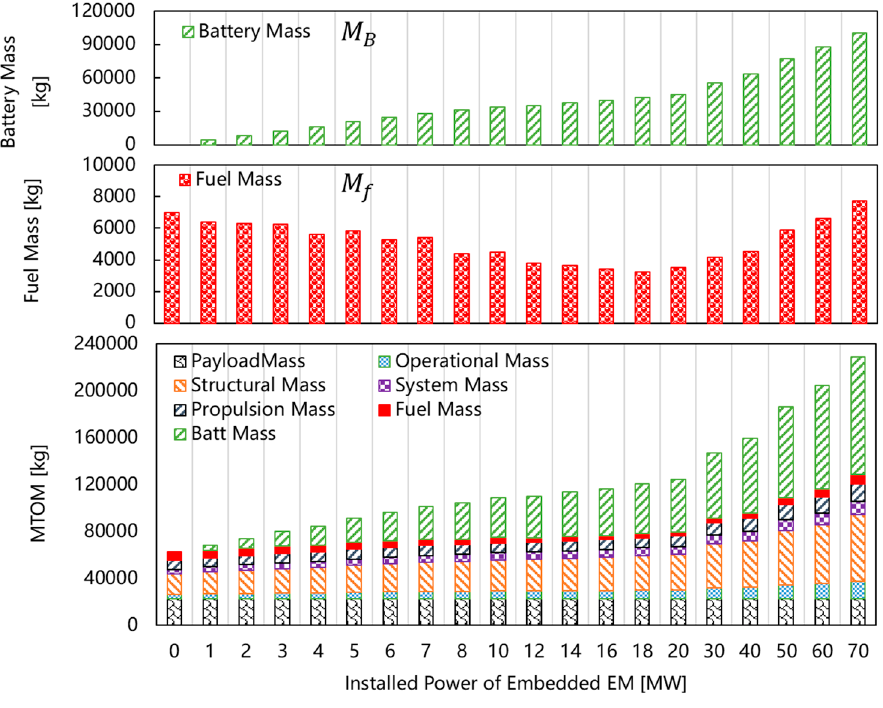
Figure 7. The variation of MTOM and its breakdown (e.g., battery and fuel mass) at different hybridising levels.